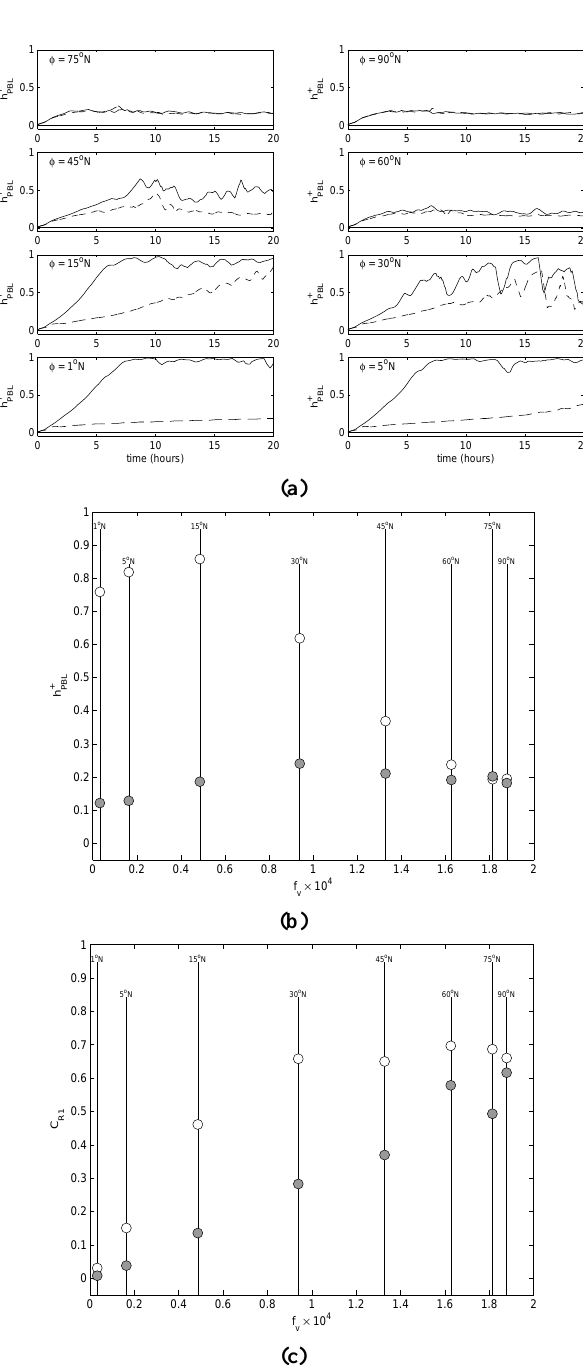
Fig. 3. The depth of the essentially turbulent EBL: (a) time evolu- = h EBL (cid:14) L z , where L z = tion of the non-dimensional depth h + EBL 3km is the vertical size of the LES domain (solid curves are for EW-EBL; dashed curves are for WE-EBL); (b) values of h + EBL at hour six of the LES integration; and (c) values of the Rossby– Montgomery parameter C R 1 for the weakly turbulent EBL at hour six of the LES integration. Shaded circles show the WE-EBL; open circles, the